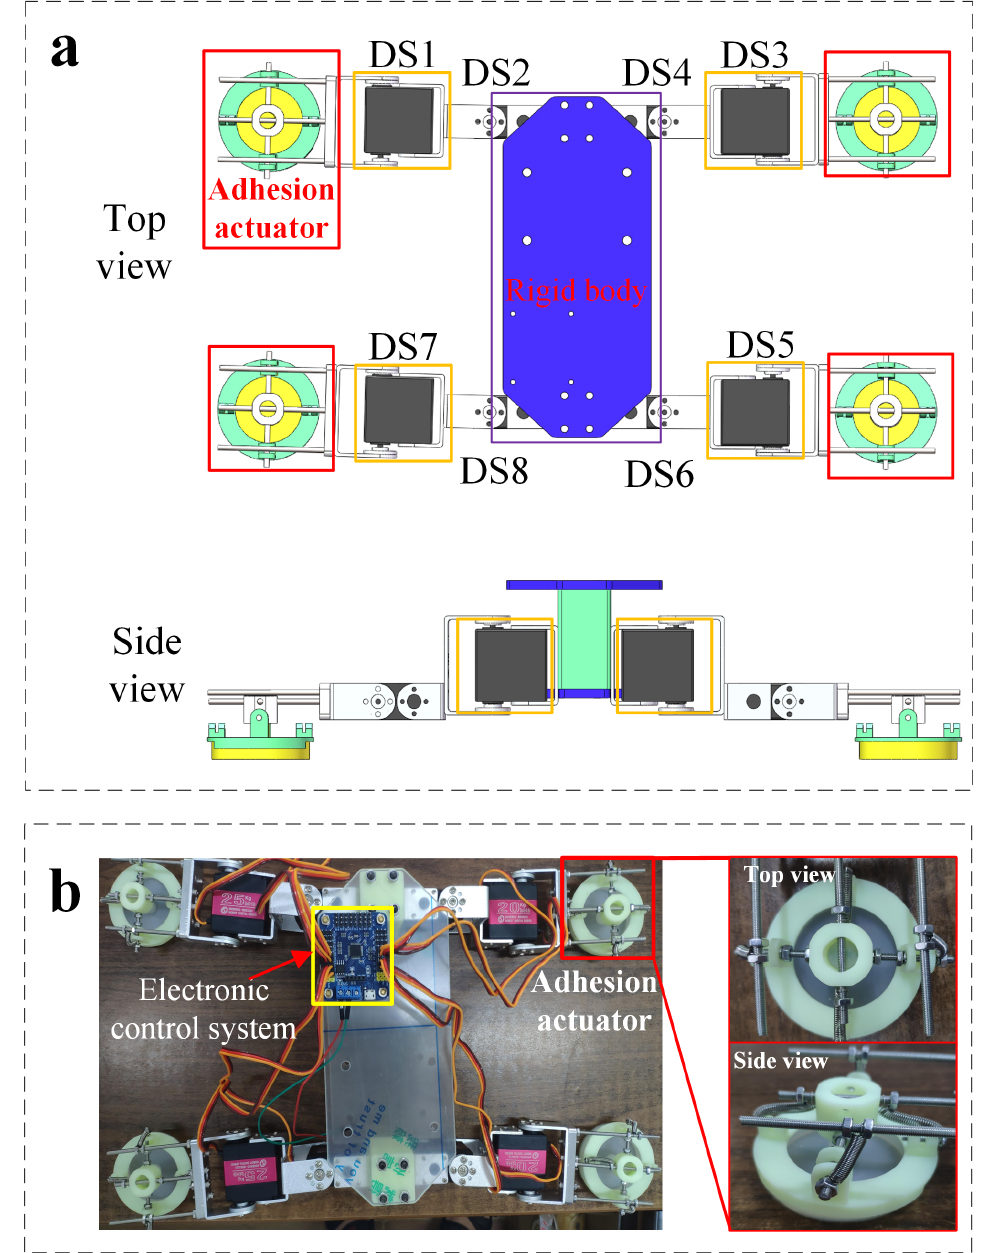
Figure 7. Design of climbing robot. ( a ) top view (bottom) and side view (top) of the schematic design of the climbing-robot composed of adhesion actuators (on the ends of the four legs with four digital servos:DS1, DS3, DS5, DS7) for switchable adhesion, and one rigid body (equipped with four digital servos: DS2, DS4, DS6, DS8) for locomotion driven by digital servos; ( b ) the initial state of fabricated climbing-robot from the design in ( a